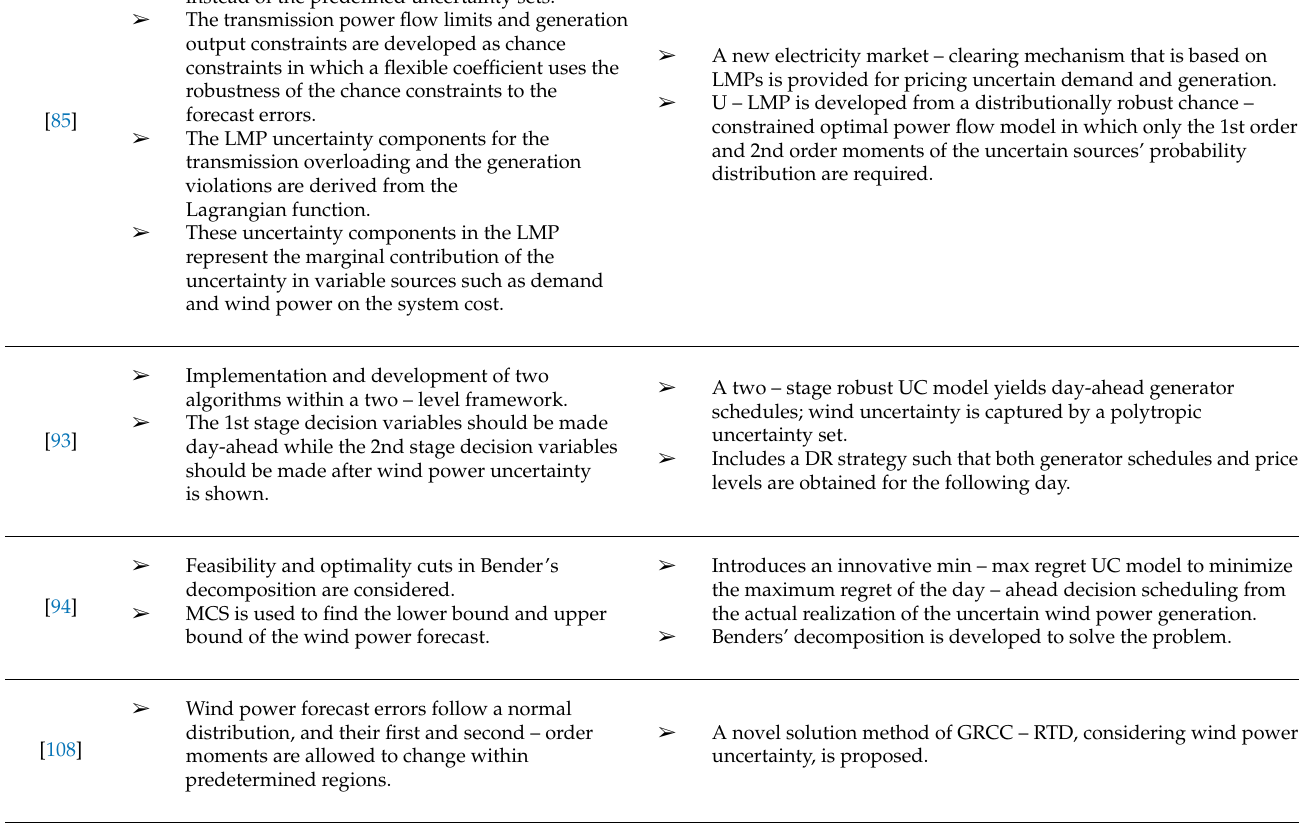
The stochastic UCP is solved using a new parameter – free self – adaptive PSO